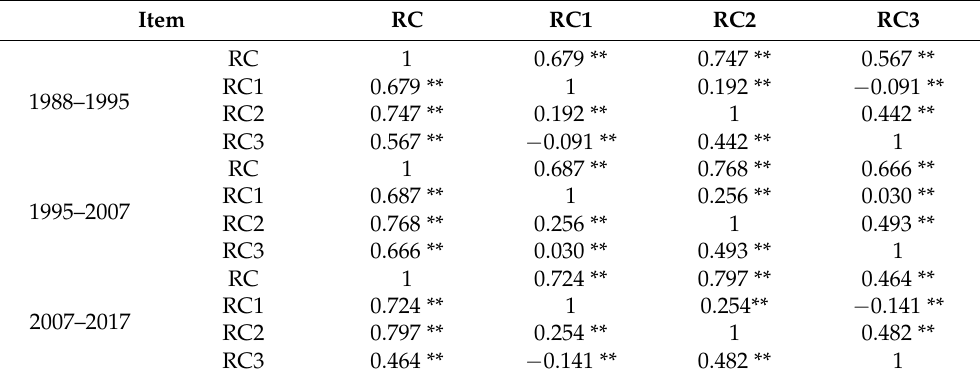
Table 6. Correlation coefficients among the resilience of different